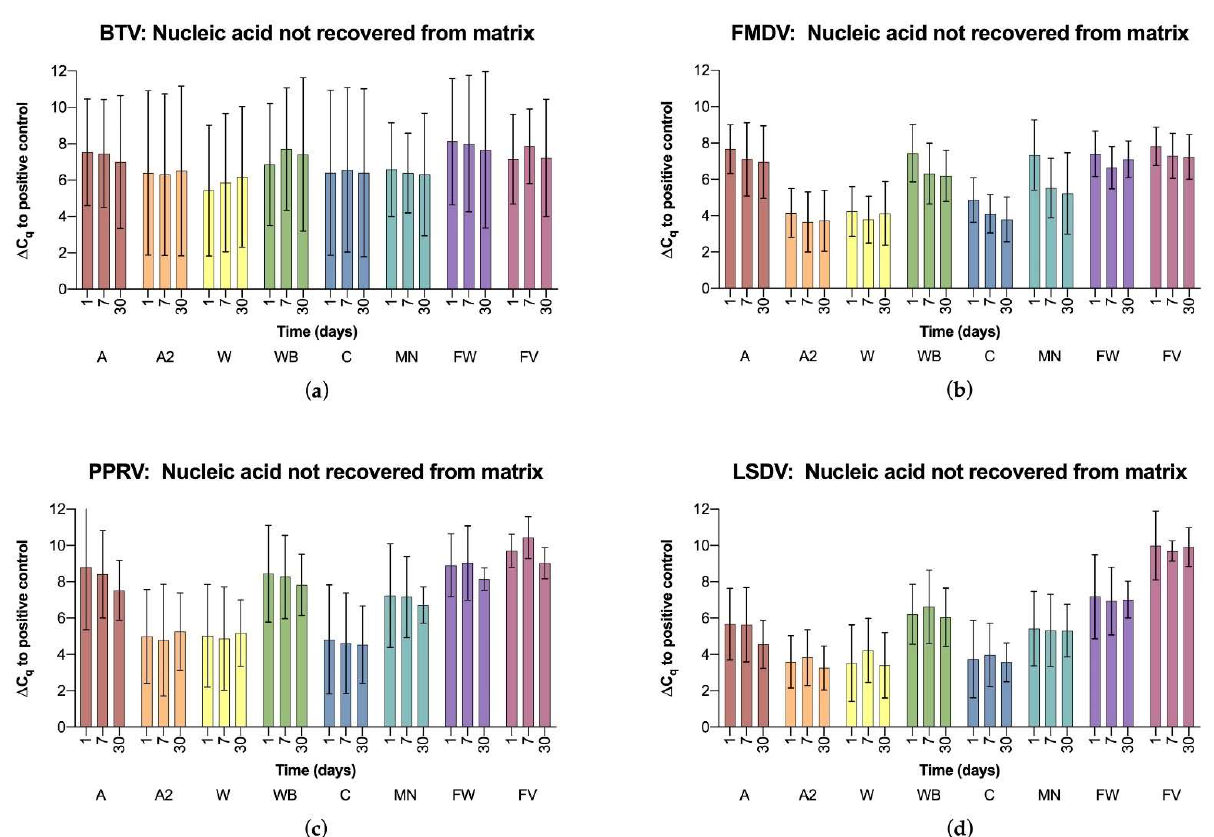
Figure 2. Stabilization and recovery of nucleic acid from cards and filters analyzed by real-time (RT)-PCR after one day, one week and one month of incubation, showing the mean ∆ C q values for each virus, sample time point, and card with their 95% confidence intervals indicated by the error bars. ∆C q values were calculated between the eluted nucleic acid and the virus preparation used for spotting (positive control). ( a ) BTV; ( b ) FMDV; ( c ) PPRV; ( d ) LSDV.